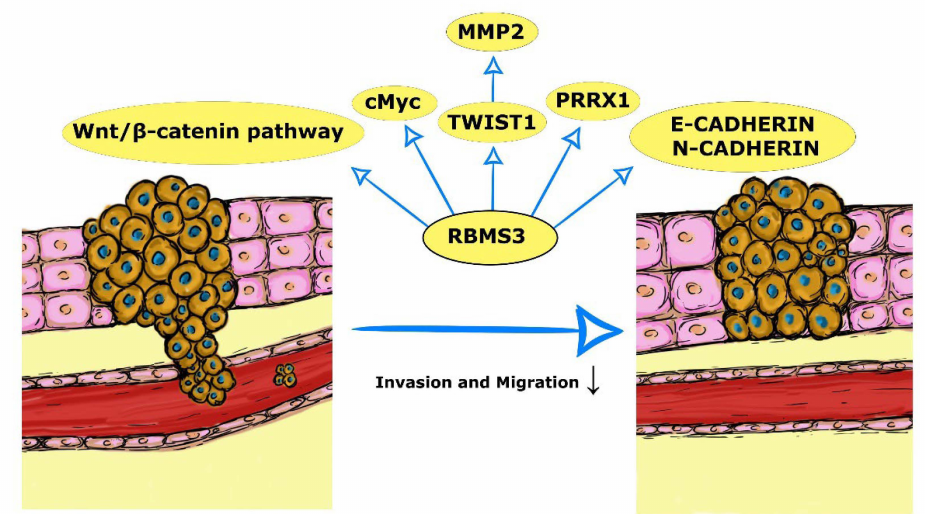
Figure 2. Mechanisms of the impact of RBMS3 on the EMT